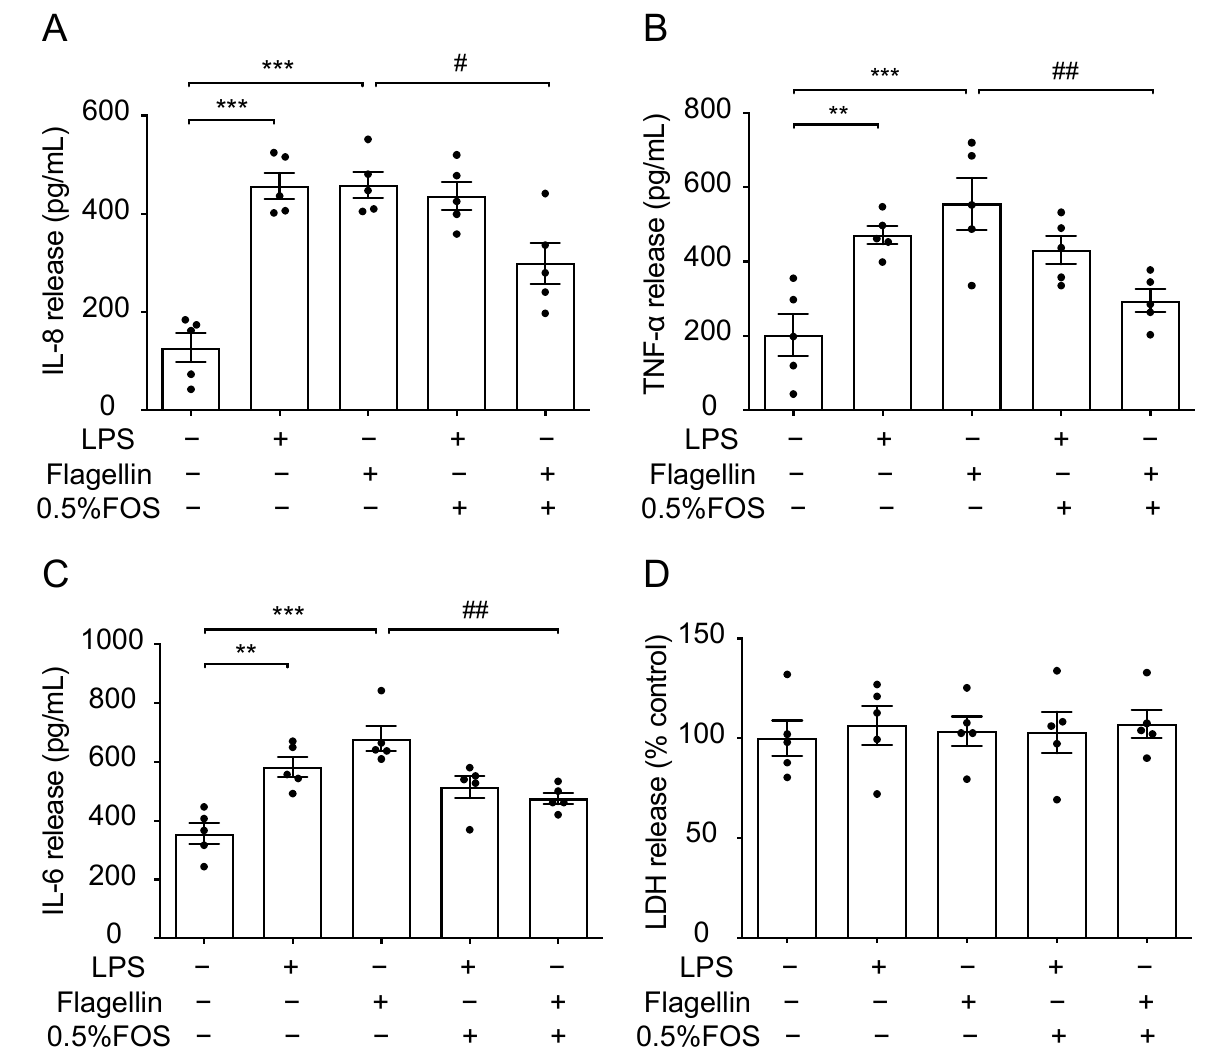
Figure 7. Anti-inflammatory effects of FOS in LPS- or flagellin-treated PBECs. ( A ) IL-8, ( B ) TNF- α , ( C ) IL-6, and ( D ) LDH release were determined in the supernatants of LPS- or flagellin-treated PBECs. Significantly different from control: ** p < 0.01; *** p < 0.001. Significantly different from flagellin: # p < 0.05; ## p < 0.01. Data are presented as means ± SEM. All data shown are representative of five independent experiments ( n = 5 donor calves, one donor calf per experiment). FOS, fructo-oligosaccharides; IL, interleukin; LDH, lactate dehydrogenase; LPS, lipopolysaccharides; TNF, tumor necrosis factor.